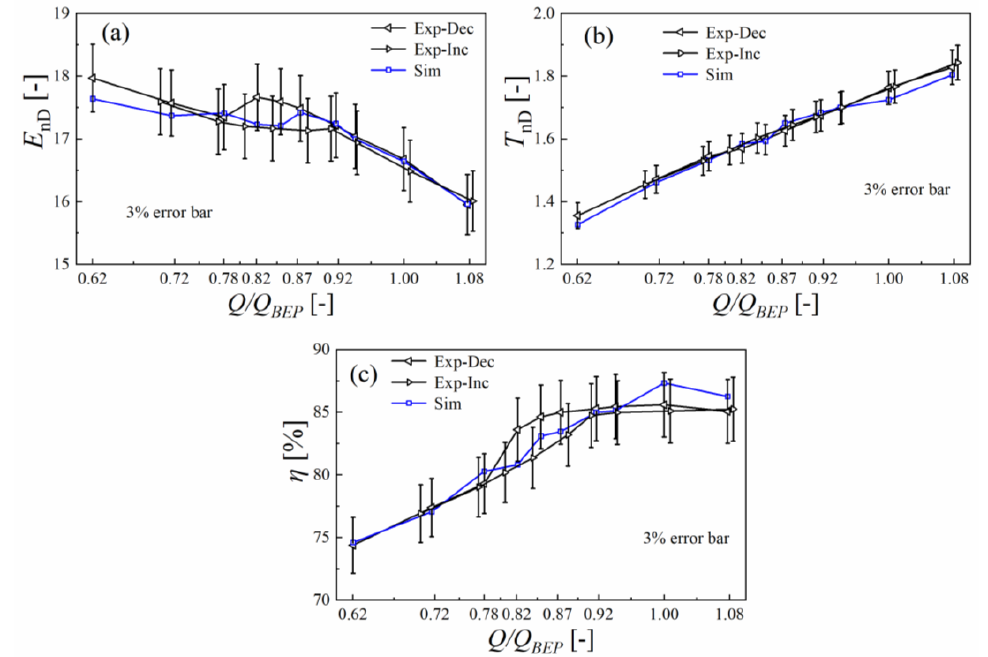
Figure 6. Experimental verification: ( a ) energy, ( b ) torque, ( c ) efficiency.